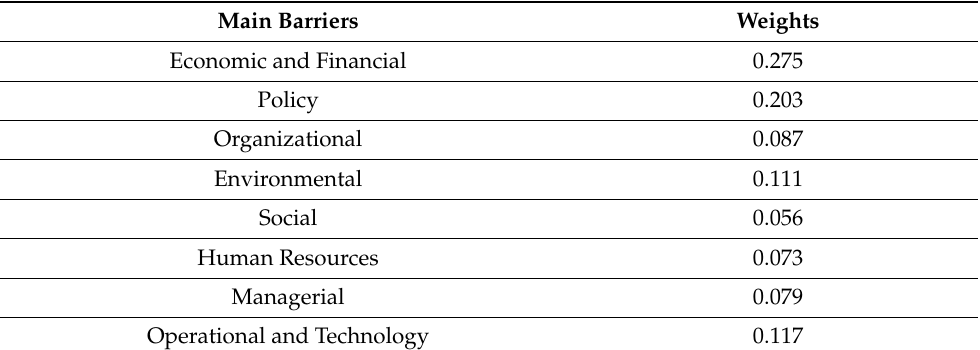
Table 4. The Weights of Main Barriers.